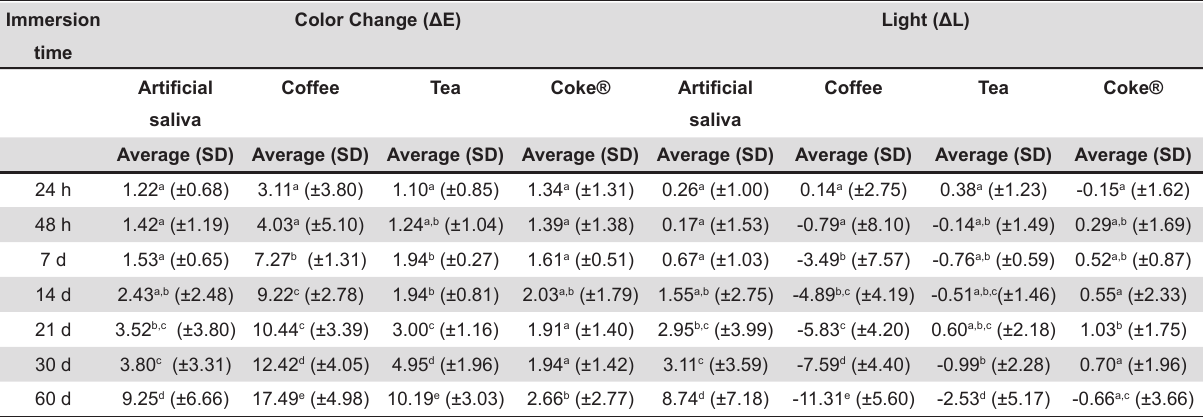
Similar letters indicate vertical statistical similarity